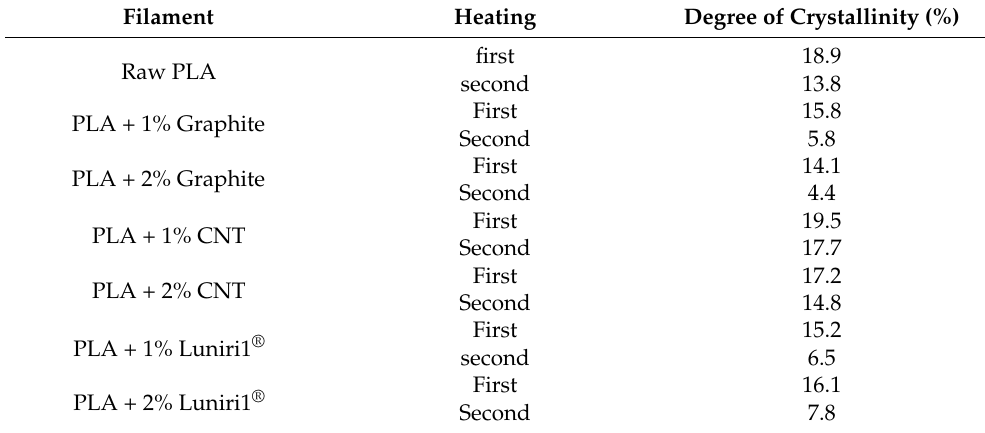
Table 6. The degree of crystallinity for different